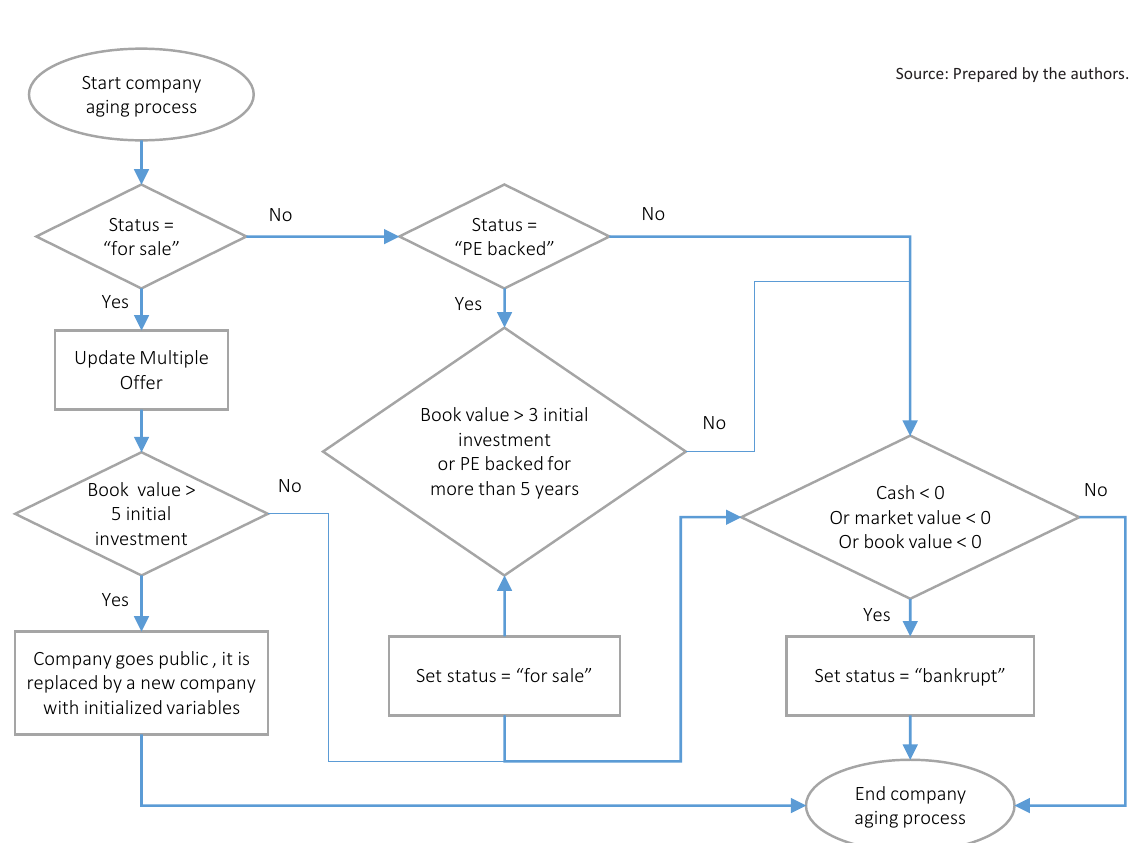
Figure 7. Flow chart of the aging